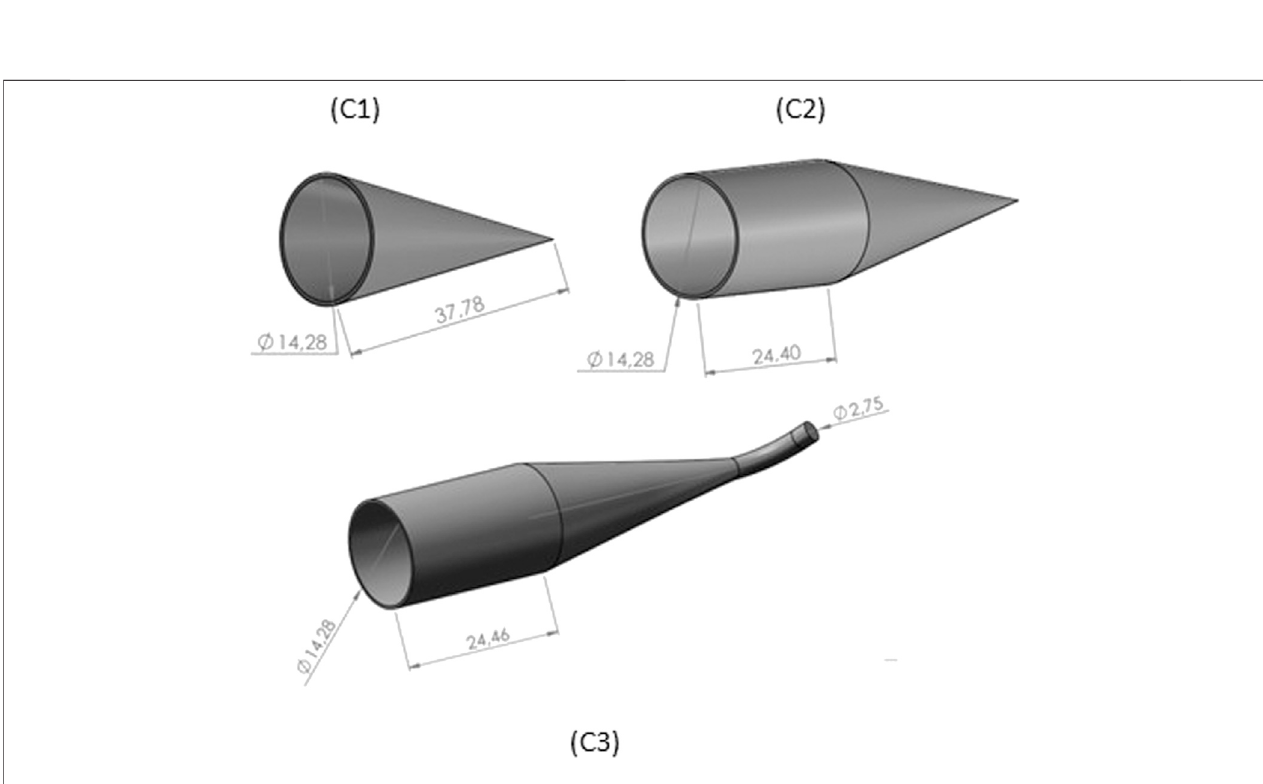
Frontiers in Physics |